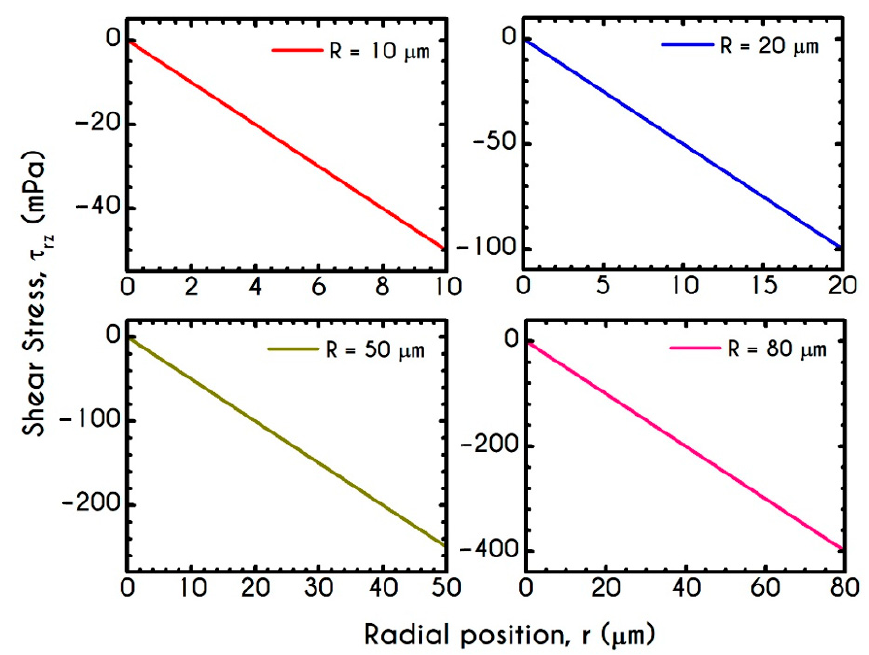
Figure 9. Shear viscoelastic stress τ ve,rz along the radial position r for tube radius R equal to 10 µ m, 20 µ m, 50 µ m, and 80 µ m for J = 10 4 Pa/m and H c =